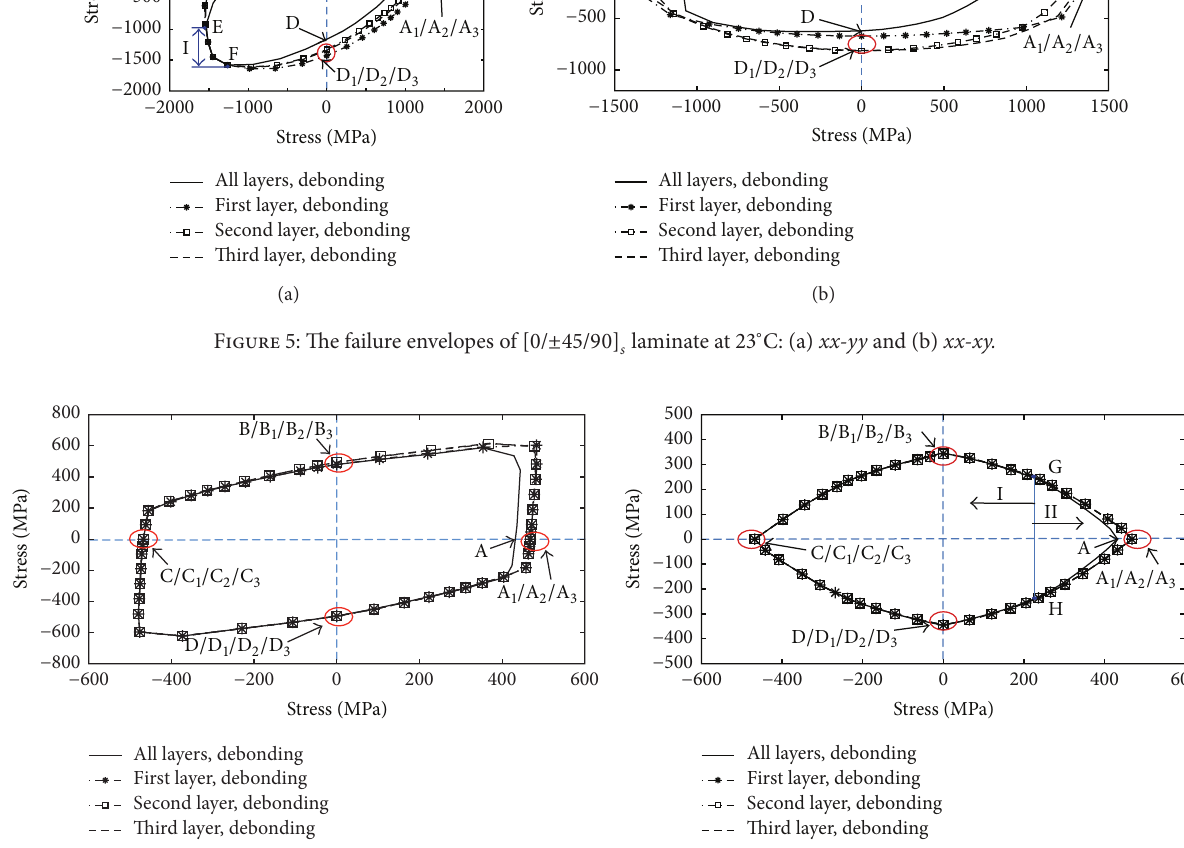
laminate at 650 ∘ C: (a) xx-yy and (b) s